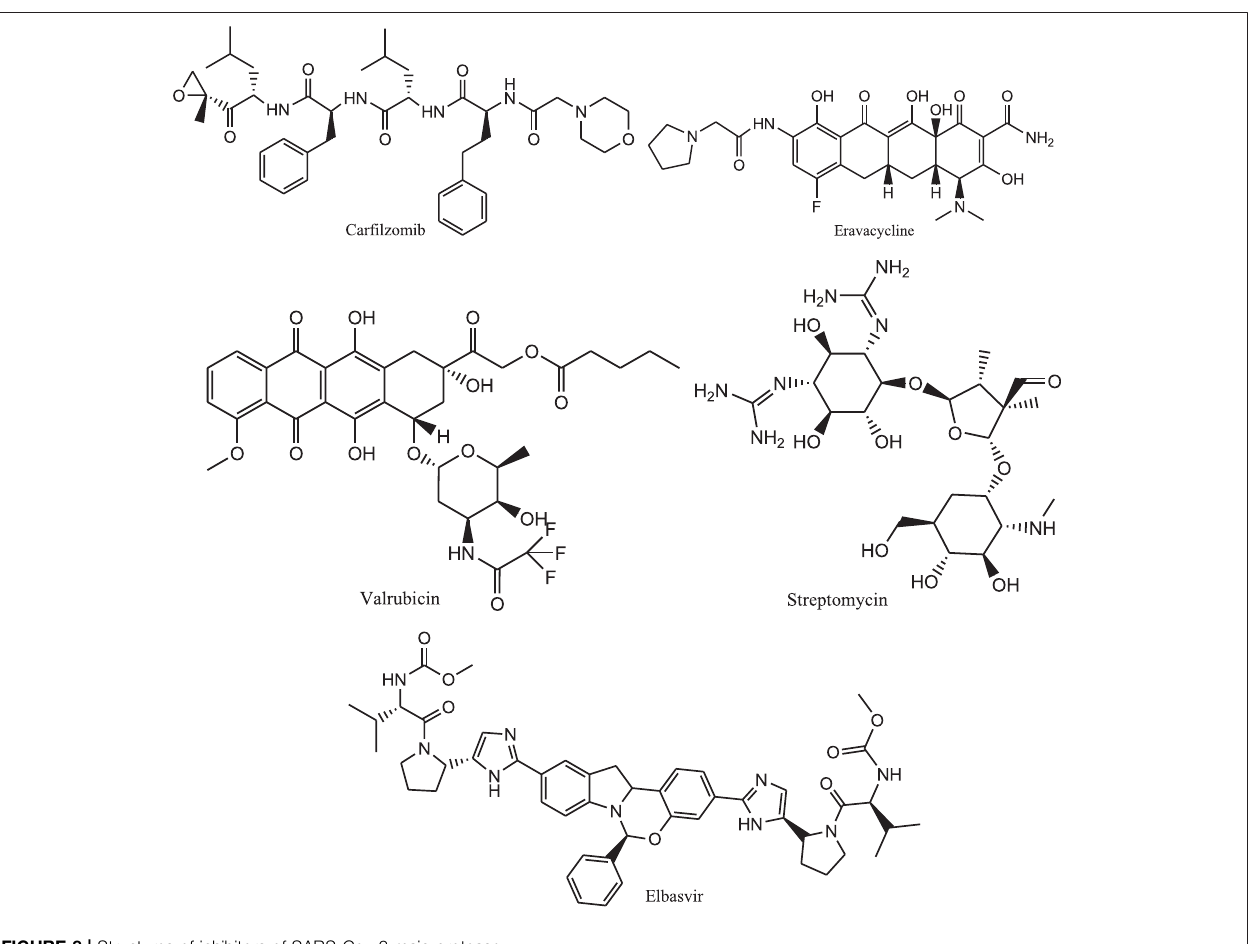
FIGURE 8 | Structures of inhibitors of SARS-Cov-2 main